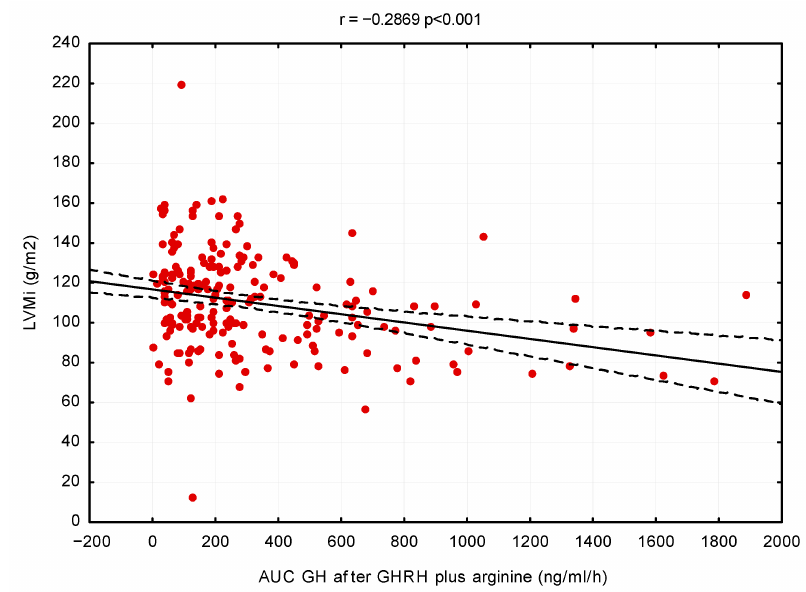
Figure 1. Linear regression between LVMi and GH secretory capacity (AUC. ng/mL/hour)–adjusted for age, sex and